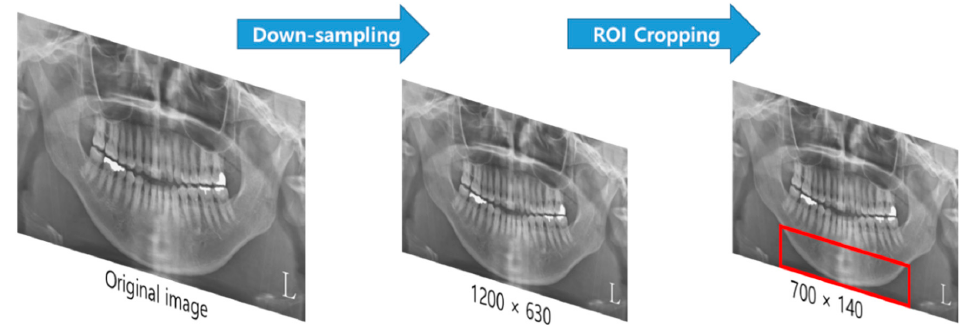
Figure 1. Image preprocessing for this study. The original DPRs were downsampled, and the ROI is restricted to the mandibular region below the teeth (region inside the bounding box). DPR,